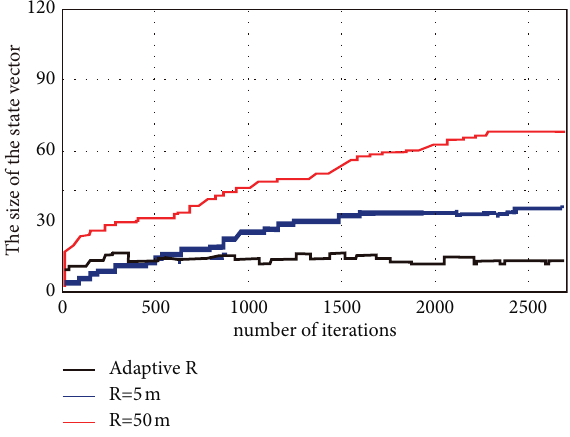
Figure 8: Size of the KF state